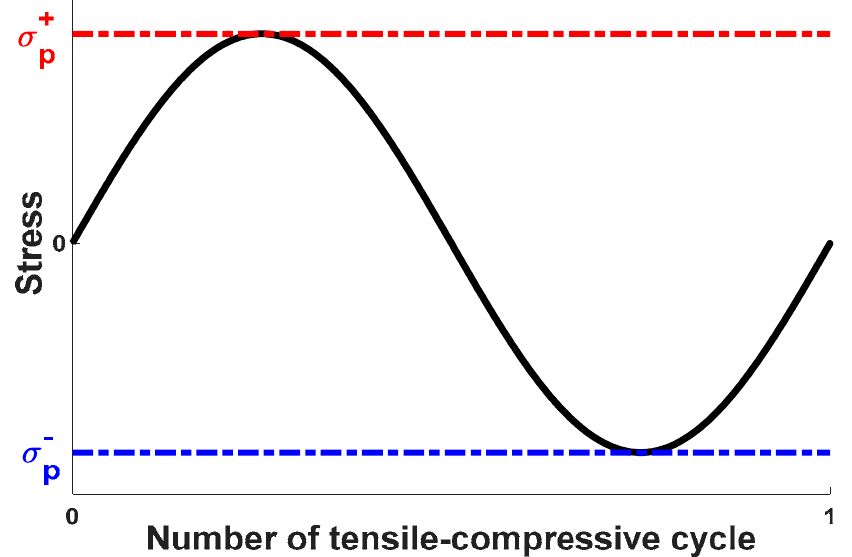
+ σ under tension and p